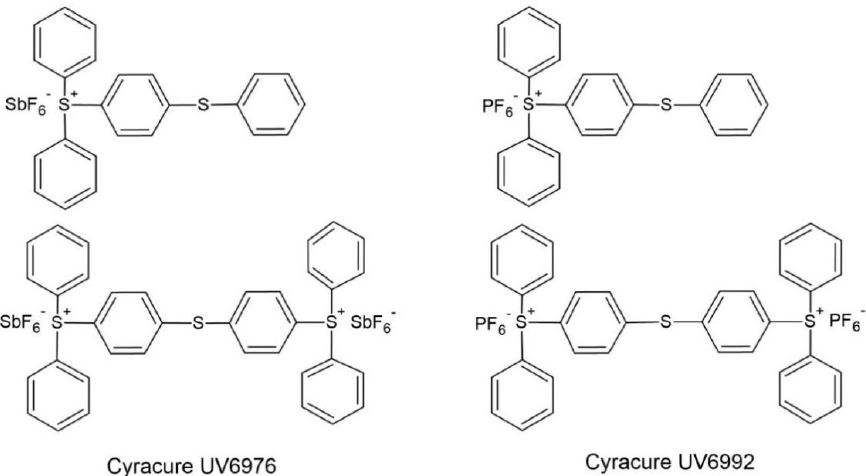
Figure 2. Structure of the cationic photoinitiators based on a triarylsulfonium cation.